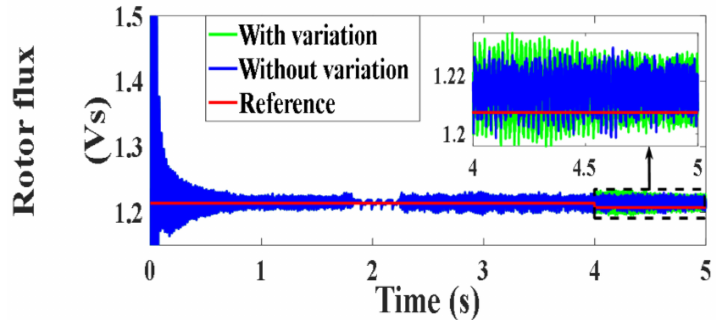
Figure 118. Rotor flux under PVC (Vs).